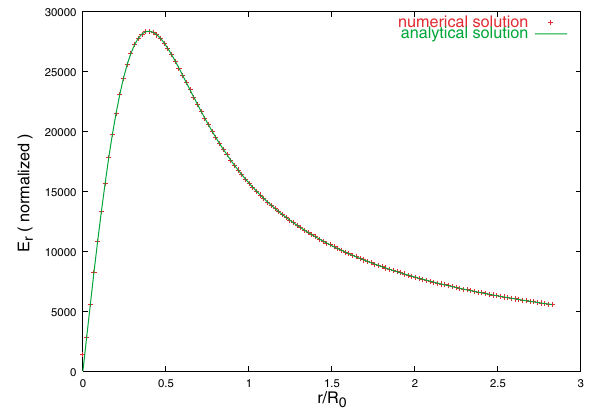
FIG. 3. (Color) Radial electric field as a function of distance along the diagonal line of the field